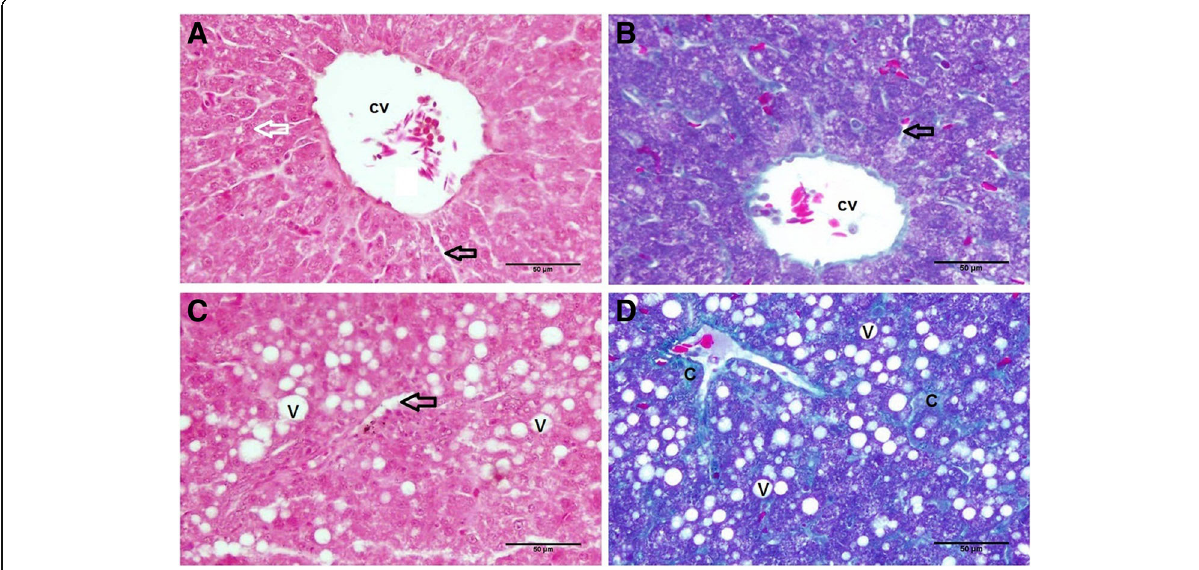
Fig. 2 Photomicrographs of hepatic tissue of control group stained with H&E stain ( a ) and crossmon trichrome stain ( b ) showing the arrangement of hepatocytes (white arrow) on the hepatic cords that radiates from the central vein (Cv), with hepatic sinusoids in between the cords (black arrow). c , d Photomicrographs of the heat-stressed liver stained with H&E stain ( c ) and crossmon trichrome stain ( d ) revealing damage of the hepatic tissue with severe hepatocyte vacuolation (V), swollen hepatic sinusoids (black arrow), and collagenous fiber depositions (C) bar = 50 μ